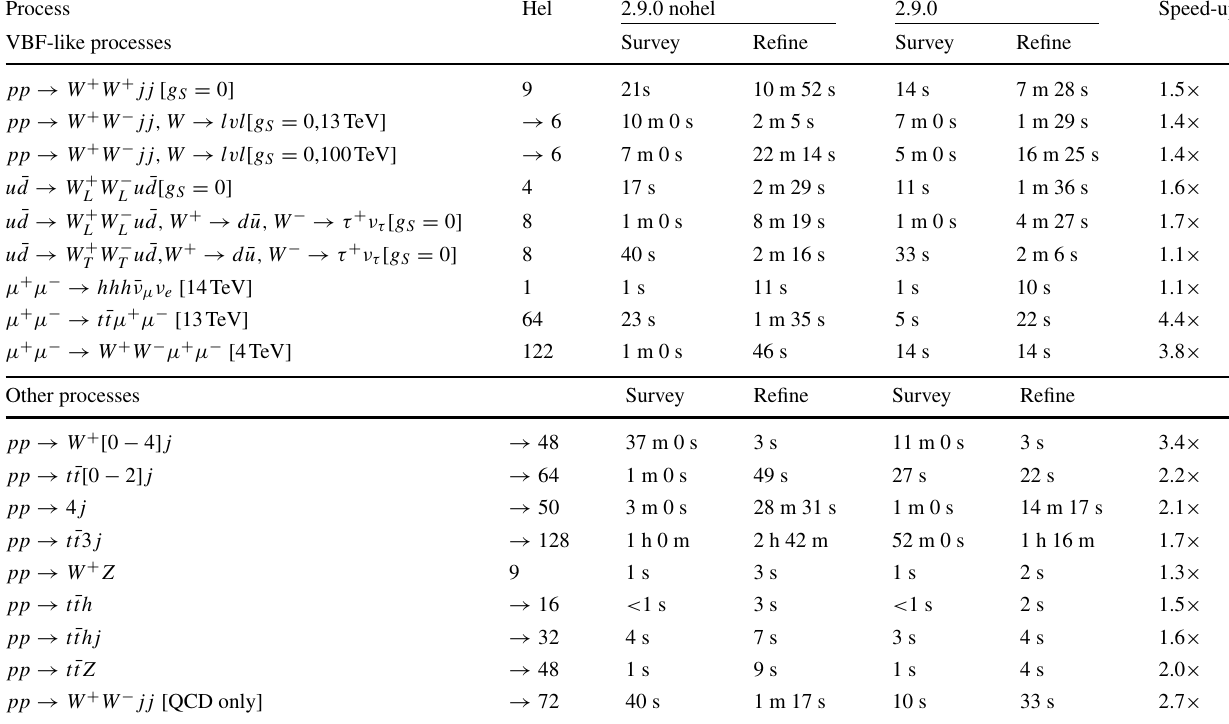
Table 4 Integration timing (time to solution) on a mac-book pro (quad-core 2016) to generate 10k events. Comparing the impact with and without helicity recycling